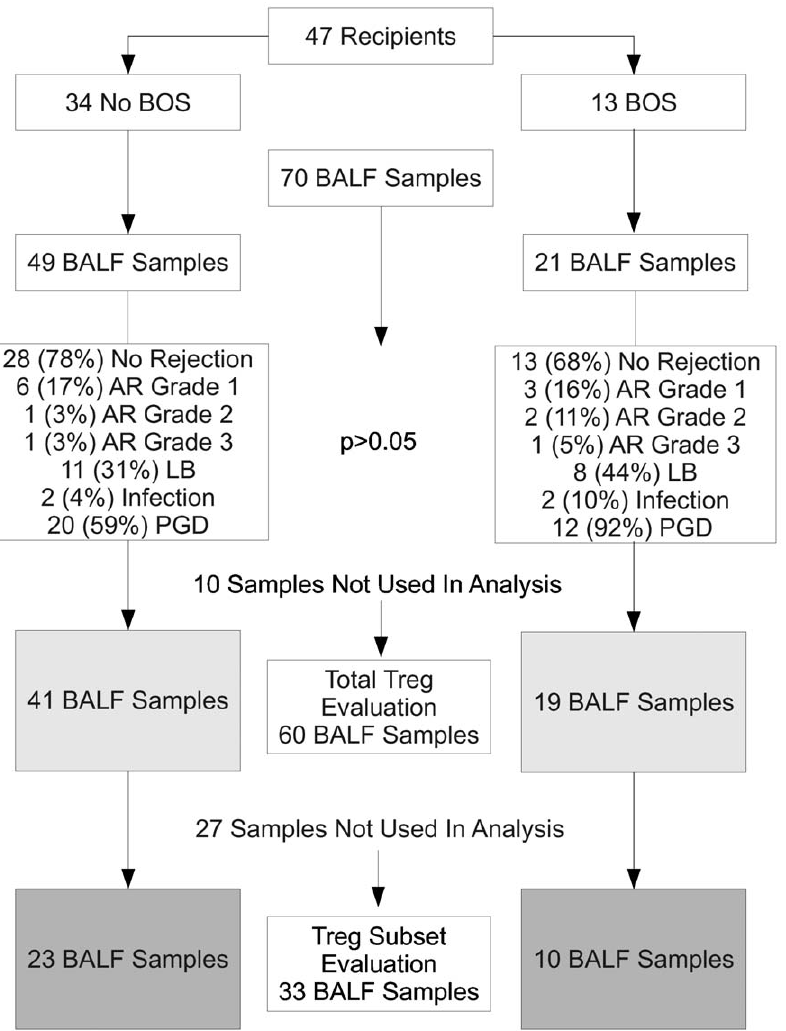
Figure 2. Flow chart description of the number of samples and outcomes from each group. Forty-seven lung transplant recipients were in the study. Thirteen went on to develop BOS. Seventy BALF samples were collected and ten had insufficient cells to allow detection of Treg, thus 60 samples were used for total Treg analysis. Of the 60 samples, 27 were dropped from analysis for the Treg subsets due to inadequate number of Treg as explained in the